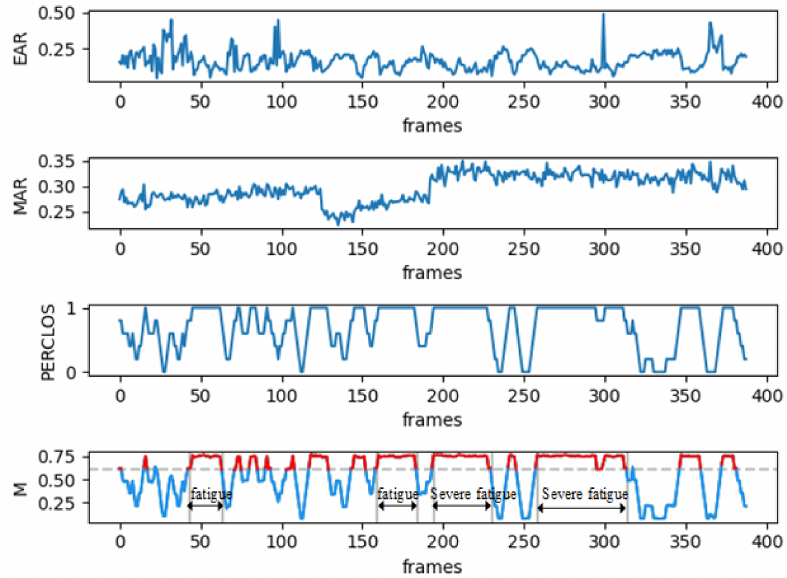
Figure 11. EAR/MAR/PERCLOS and M under drowsy driving.